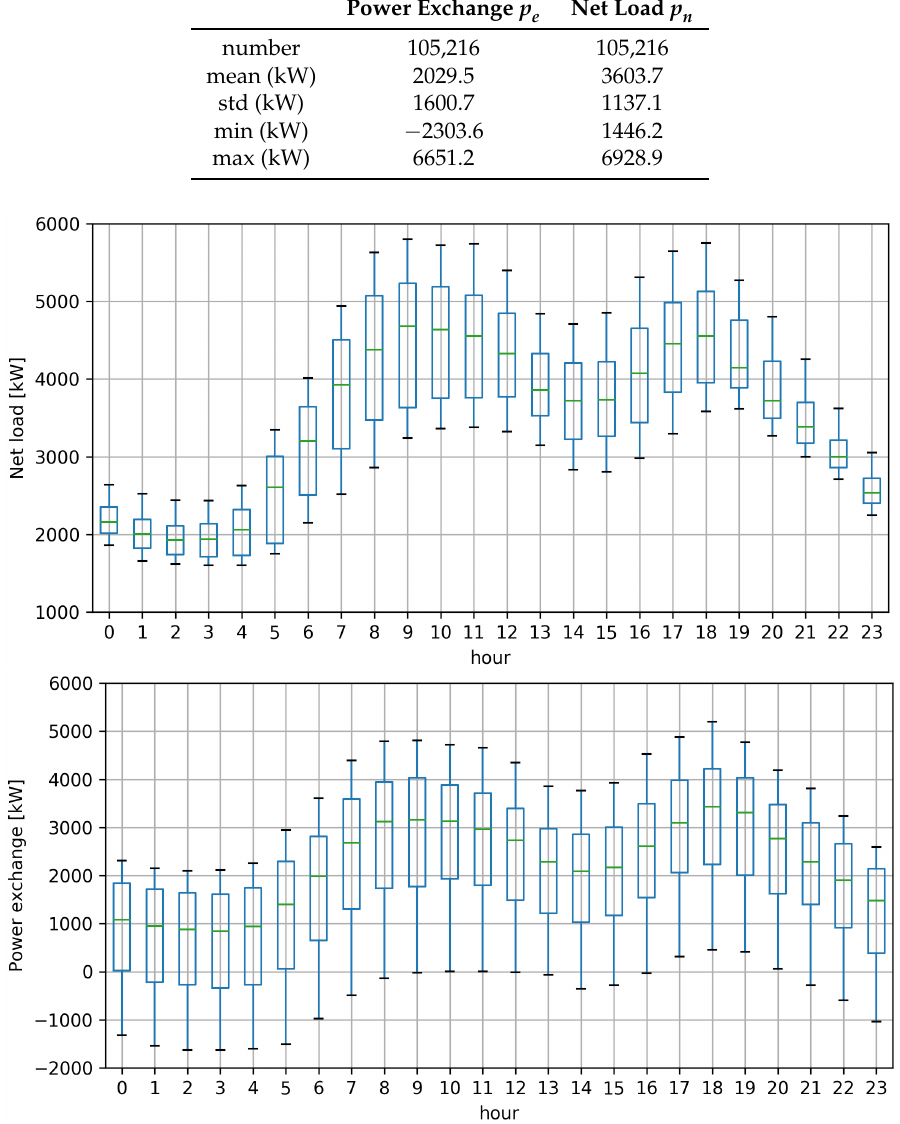
Figure 2. Box plots of the net load and of the power exchange of the microgrid. The box represents the interquartile range, the line in the box is the median, and the whiskers are set at the 5 and 95 percentile of the data